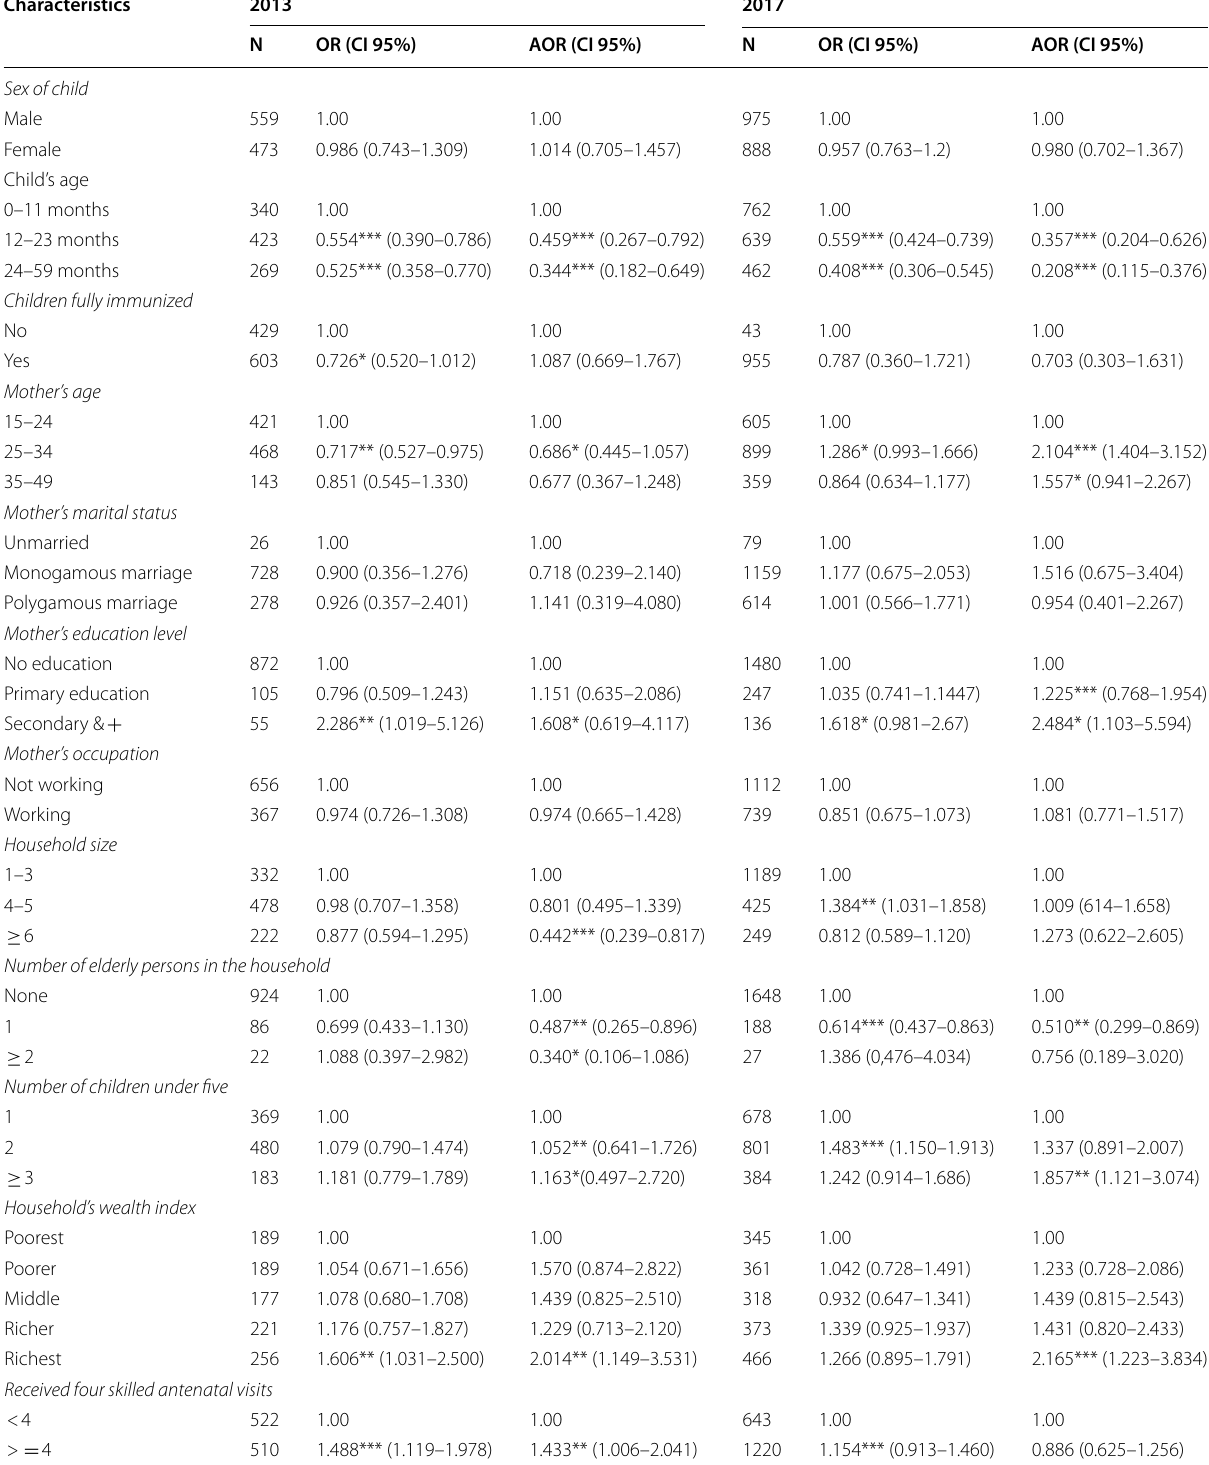
Table 3 Factors associated with healthcare utilization for fever from the baseline (2013) and endline (2017) survey data on the impact evaluation of Performance-Based Financing (PBF) in Burkina